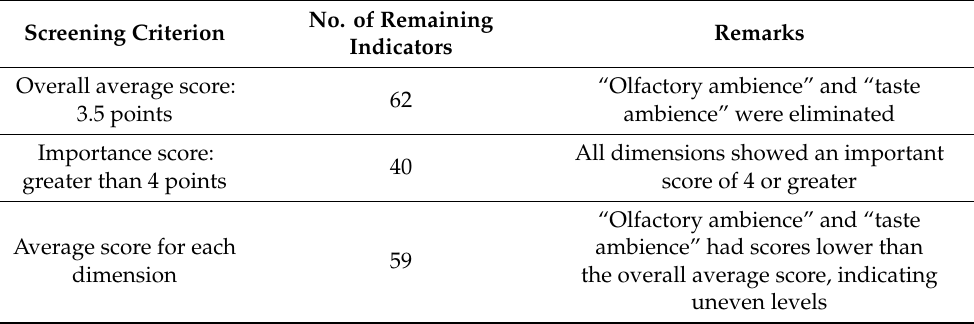
Table 2. Comparison of the screening results for the indicators using di ff erent criteria. Screening